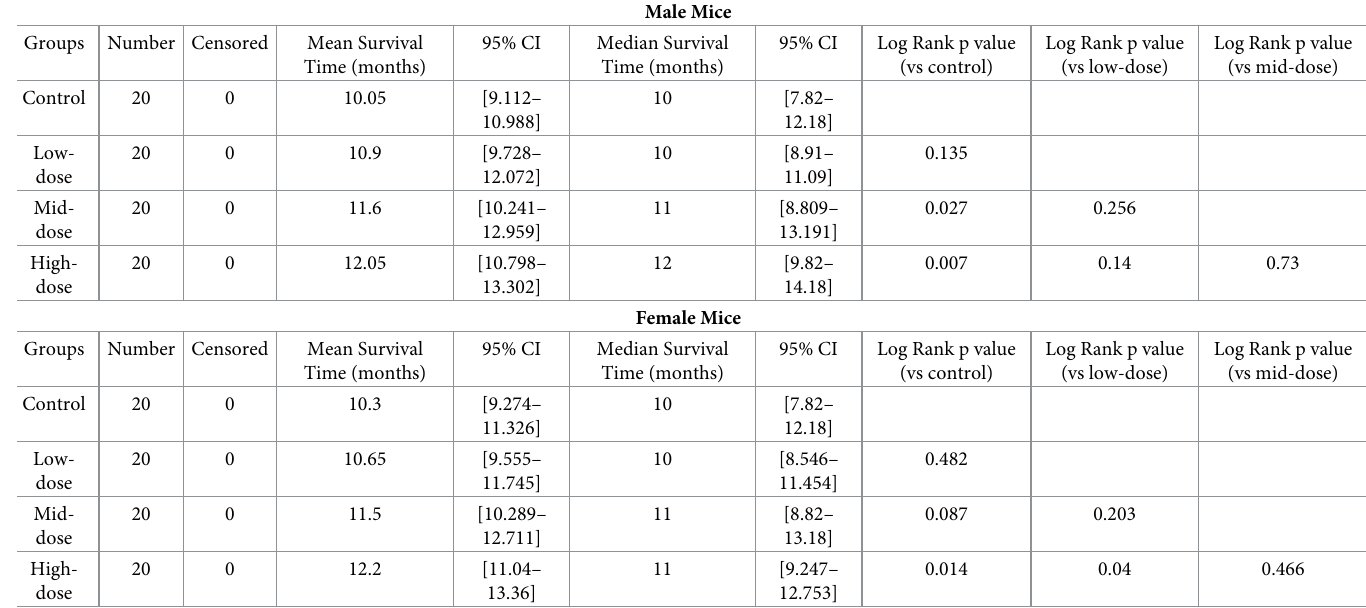
Table 2. Statistical analysis of mean and median survival time in male and female SAMP8 mice after exposure to erinacine A-enriched H . erinaceus mycelia.